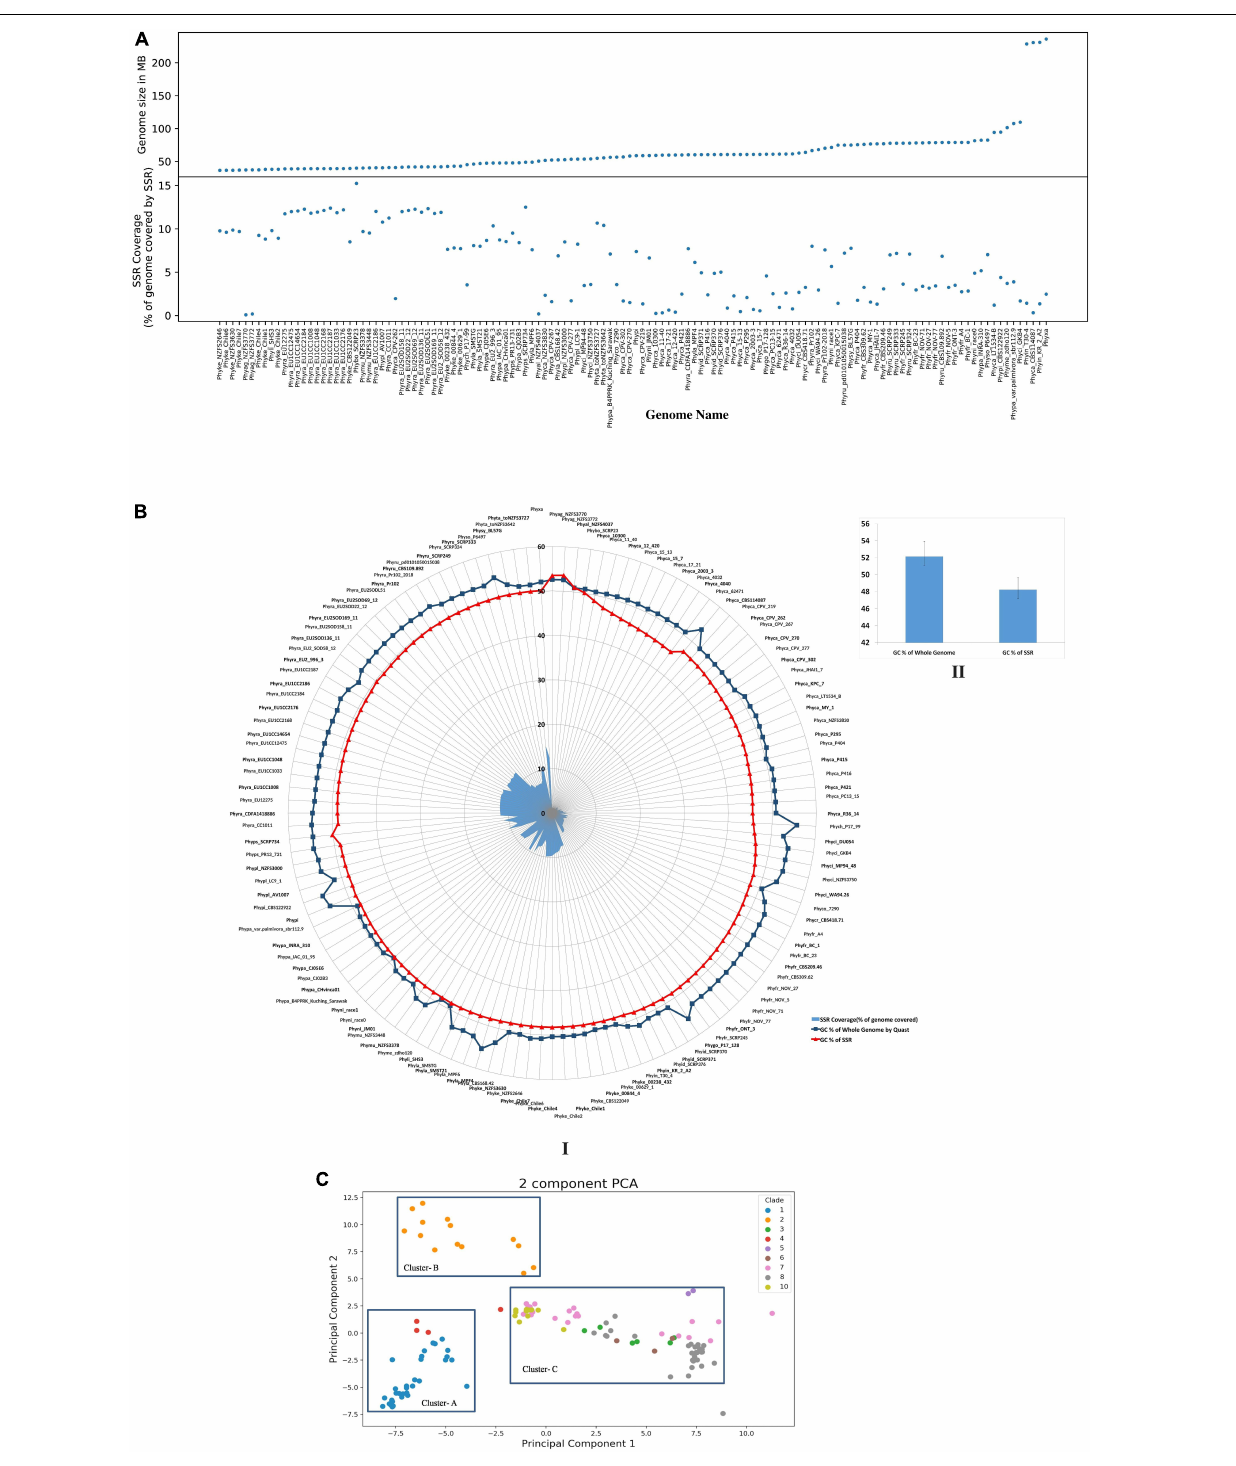
Frontiers in Microbiology |